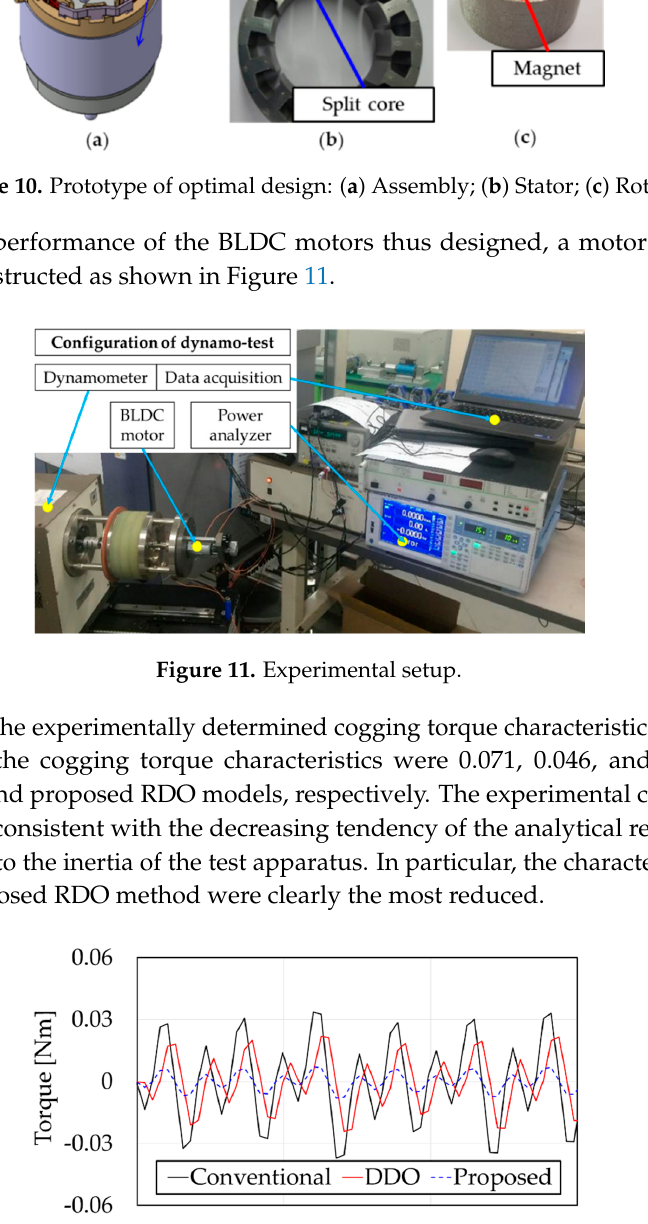
Figure 12. Comparison of experimentally determined cogging torque characteristics.